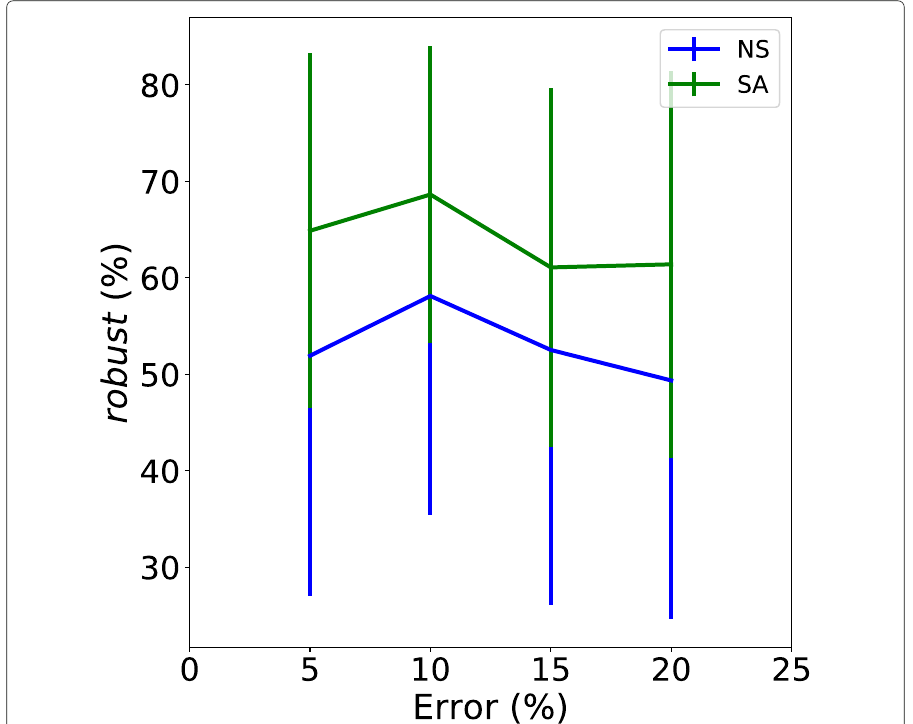
Fig. 12 Winters. Even with slow heater, SA is better or comparable than NS. Error bars indicate the variation in different simulated scenarios. For system to be more robust, the length of error bar should be